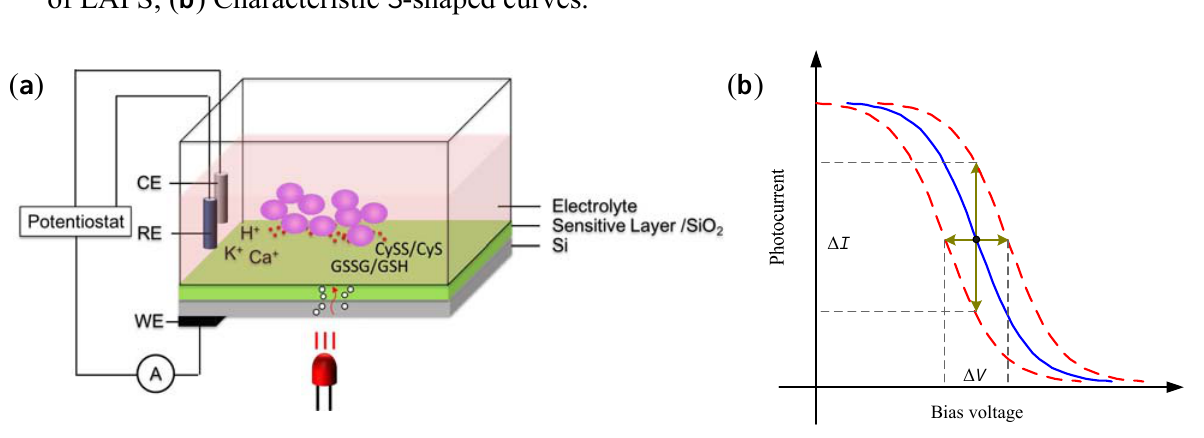
Figure 6. The schematic diagram of LAPS as a cell-based biosensor. ( a ) Working principle of LAPS; ( b ) Characteristic S -shaped